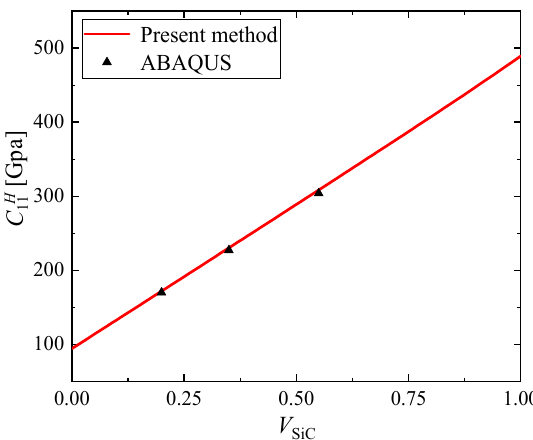
Figure 5. C 11 H obtained using the present method and the AHM on Abaqus [15].